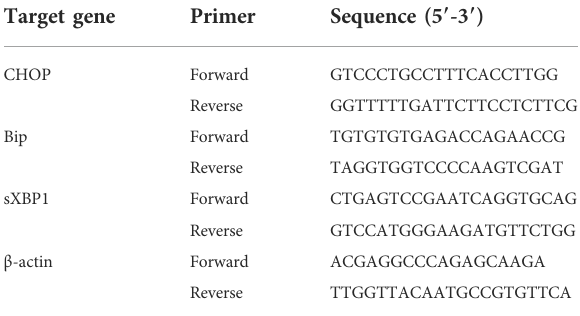
TABLE 1 Primers used for quantitative real-time